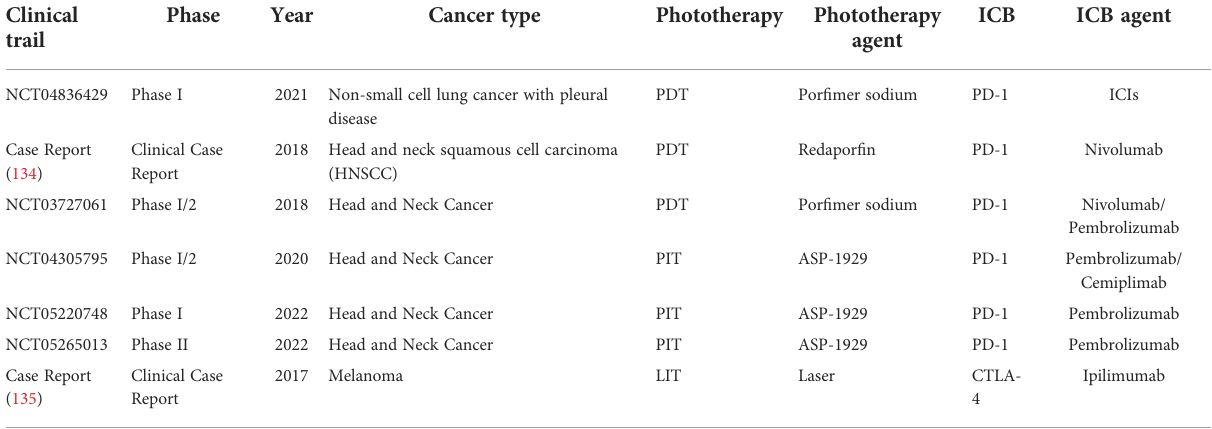
TABLE 2 Clinical trials of combination of phototherapy and ICB therapy in malignant tumors. Clinical